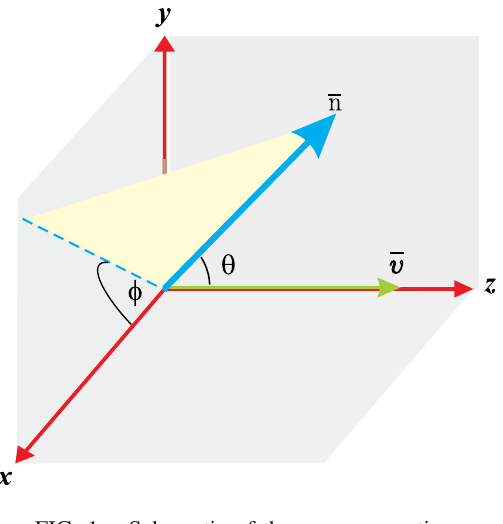
and FIG. 1. Schematic of the axes